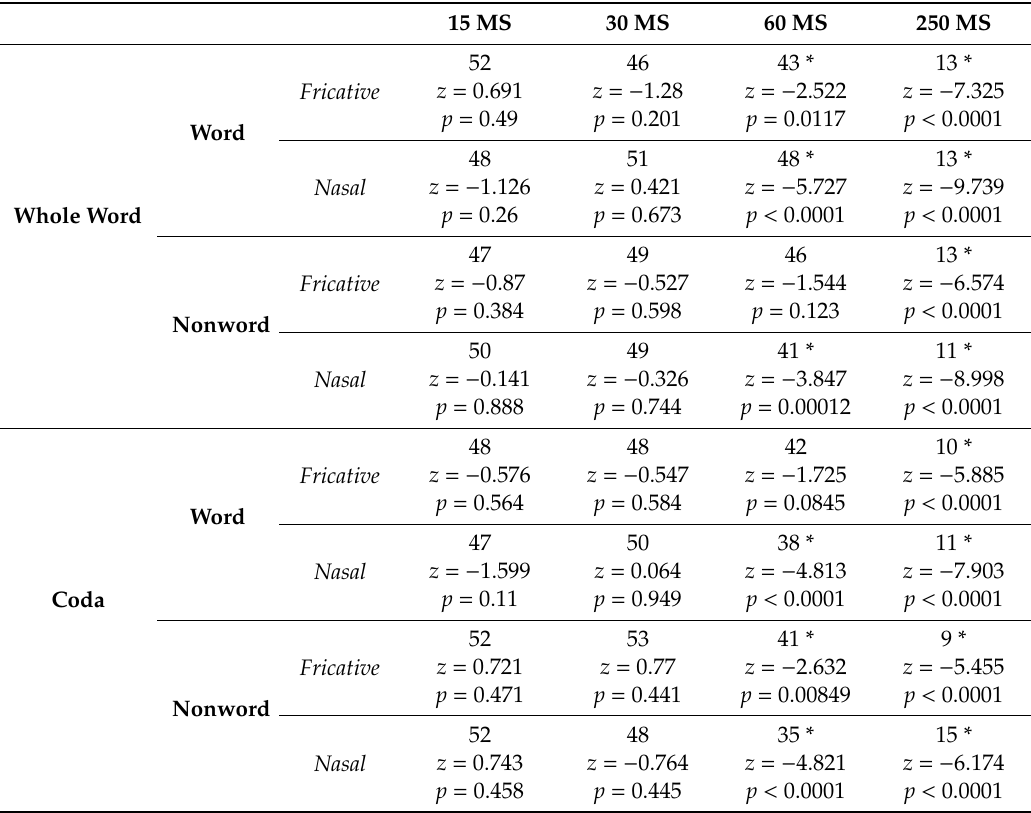
Table 2. Error rates (%) for length of duration condition separated by experimental conditions. Z-scores and estimated p -values included below error rates. Error rates that significantly di ff er from chance marked with * and shaded